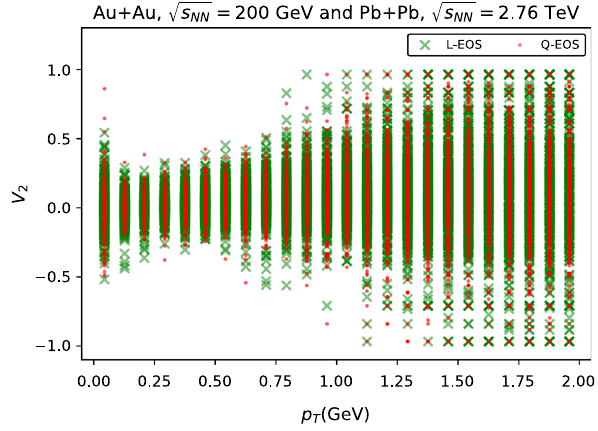
bol depict the observables with L-EOS and Q-EOS, respectively. These events are generated in different centrality bins with T s w = 137 MeV in two collision systems